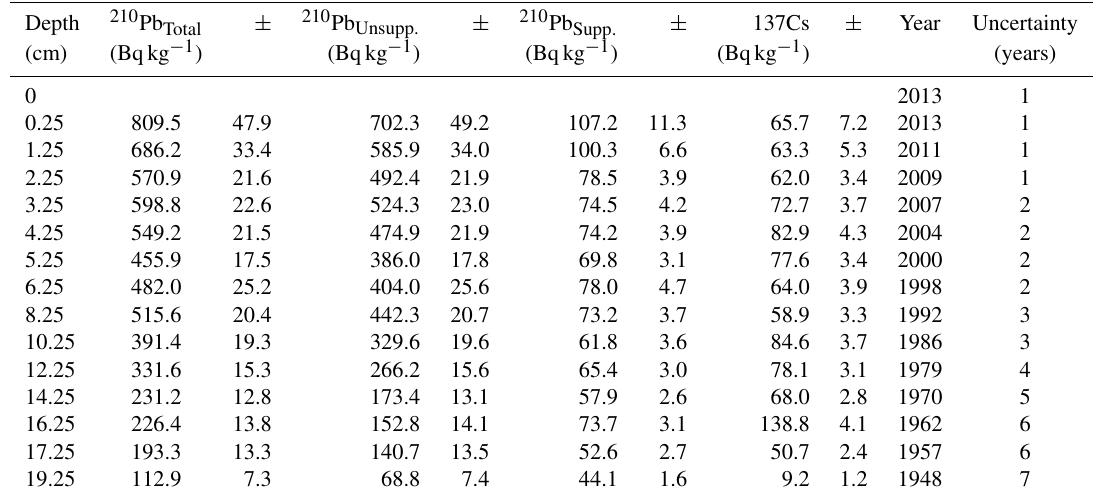
Table 4. Fallout radionuclide concentrations and chronology for FLS113 from Flyginnsjøen. Depth